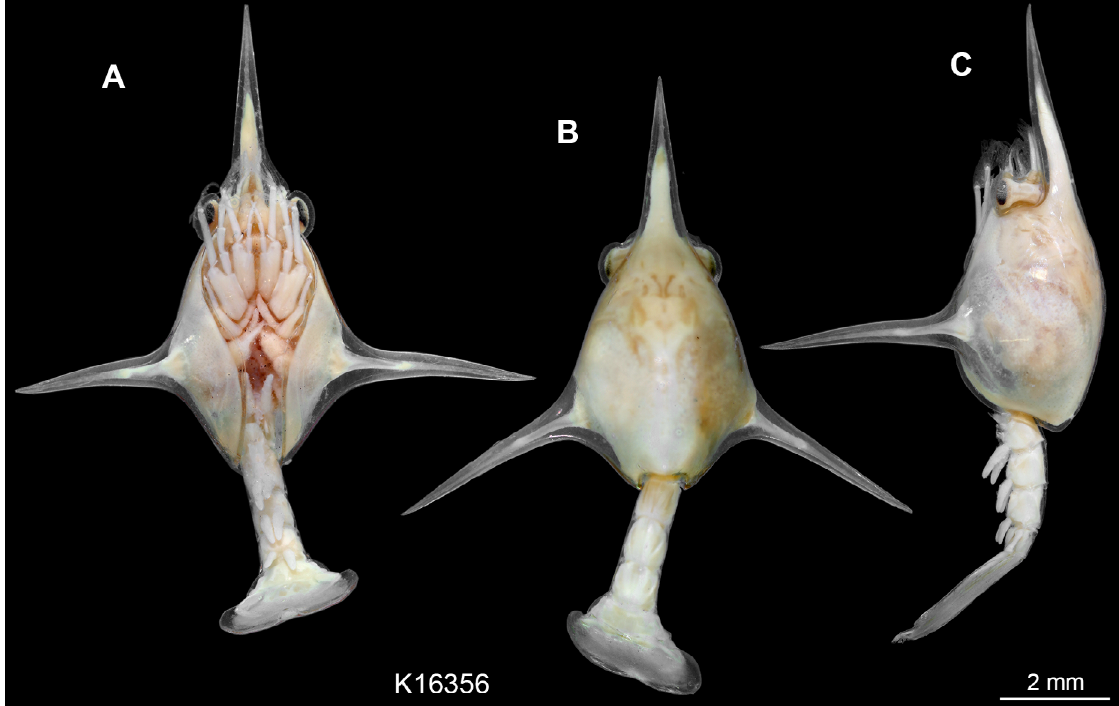
Figure 1. Larva of the group Hippidae, museum specimen ZMH-K16356 under cross-polarized light. A : Ventral view. B : Dorsal view. C : Lateral